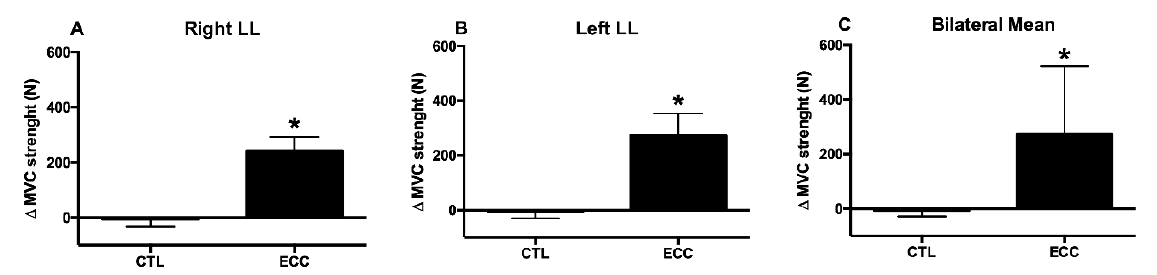
Figure 1. Comparison of the changes (Post-Pre) in maximum muscular strength after training in Newtons (N) between CTL and ECC (A). Δ Maximum strength right LL, (B). Δ Maximum strength left LL, and (C). Δ Mean bilateral maximum strength. Results are shown as mean (SD) Strength Asymmetry